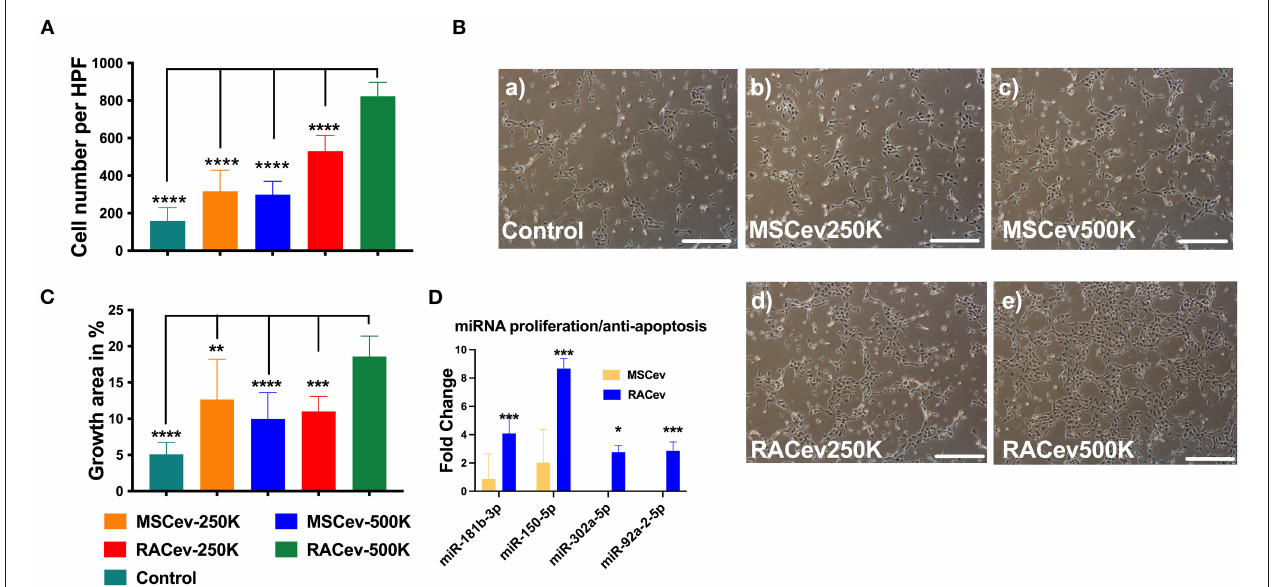
FIGURE 2 | RACev enhanced endothelial cell proliferation in a dose-dependent manner. (A,B) 5 *10 5 RACs-derived EVs (500K) increased the cell numbers and (B,C) growth area in culture dishes. (D) The miRs responsible for proliferation and anti-apoptosis were markedly upregulated in RACev vs. MSCev. * P < 0.05; ** P < 0.01; *** P < 0.001; **** P < 0.0001 for RACev-500K vs. other groups. Statistical significance was determined using one way ANOVA followed by Tukey’s multiple comparison test. The results are presented as mean ± SEM ( n = 7–10 per